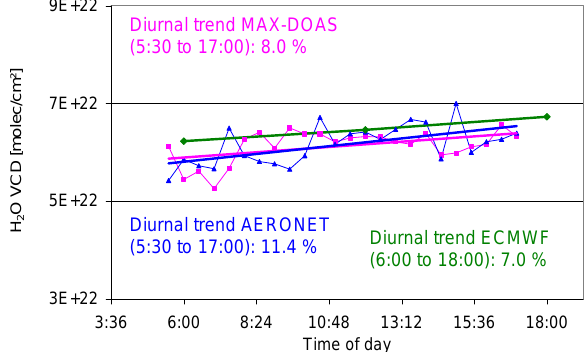
Fig. 13 Diurnal variation of H 2 O VCD derived from MAX-DOAS (pink), AERONET (blue) Fig. 13. Diurnal variation of H 2 O VCD derived from MAX-DOAS and ECMWF data (green). Data are averaged between 5:00 and 17:00 for all days , for which (pink), AERONET (blue) and ECMWF data (green). Data are aver- MAX-DOAS data are available. aged between 05:00 and 17:00 for all days, for which MAX-DOAS data are available.